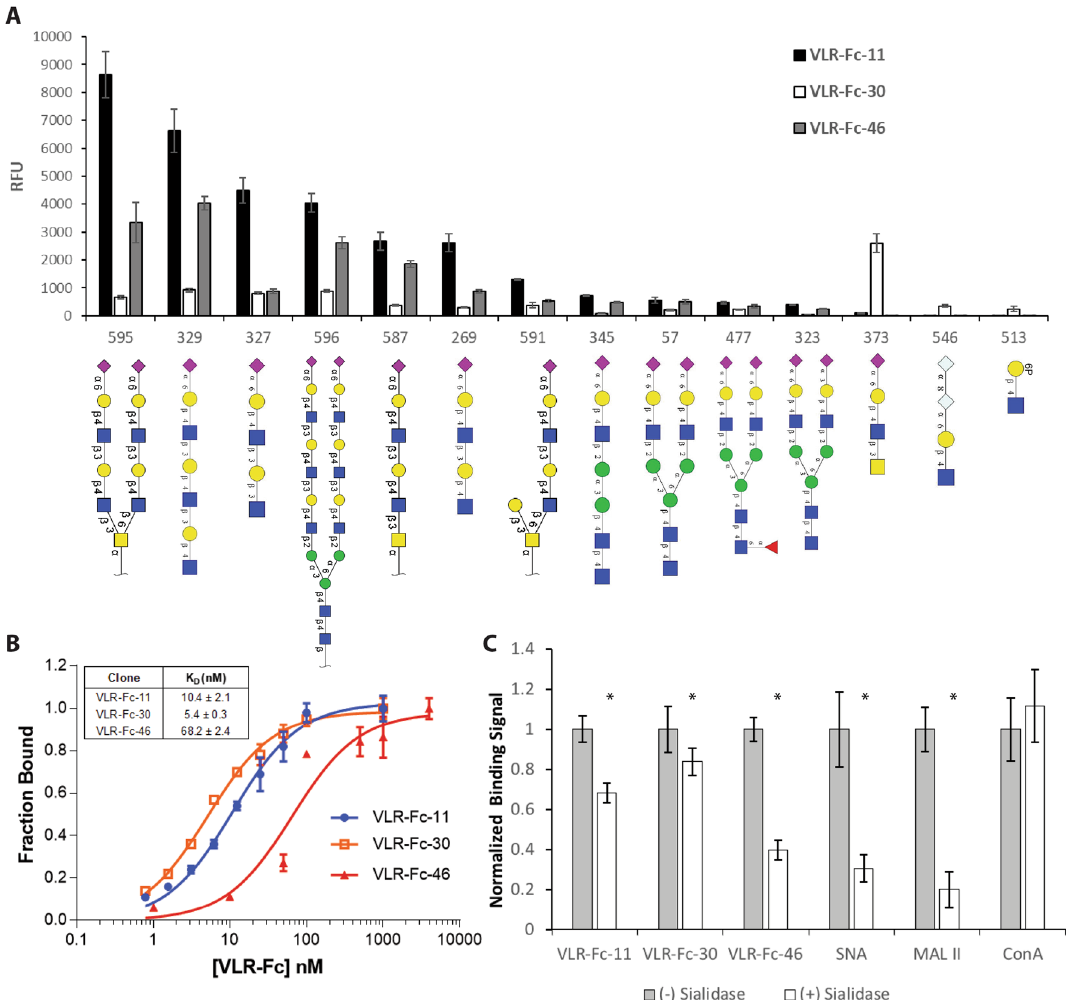
Figure 6. Antigen-binding characterization of lead VLR-Fc clones. ( A ) VLR-Fc binding to glycans on the CFGv5.3 mammalian glycan array. Comparison of binding strength of the top 10 glycans recognized by each VLR-Fc is shown and rank ordered by VLR-Fc-11 binding intensity. The glycan ID number and structure are shown along the x-axis. RFU = relative fluorescence units is plotted as mean ± S.D. Raw data used to generate this plot can be found in Table S2. ( B ) Apparent affinity of each VLR-Fc was measured via equilibrium titration on cultured MBECs. The mean fitted equilibrium dissociation constant (K D ) ± the 95% confidence interval calculated from n = 3 independent titrations is reported. ( C ) VLR-Fc or lectin binding to MBEC monolayers with and without sialidase pre-treatment. For each protein tested, the background-subtracted binding signal is normalized to MBEC binding without sialidase pre-treatment. VLR-Fc are compared to lectins that bind α2-3 (MAL II) or α2-6 (SNA) linked sialic acids and ConA which binds to α-linked core mannose residues. Bars with the mean ± S.D. are plotted. A two-tailed students t-test on n = 6 replicates was used to determine statistical significance * p < 0.05. SNA = Sambucus nigra lectin, MAL II = Maackia amurensis lectin 2, ConA = Concanavalin